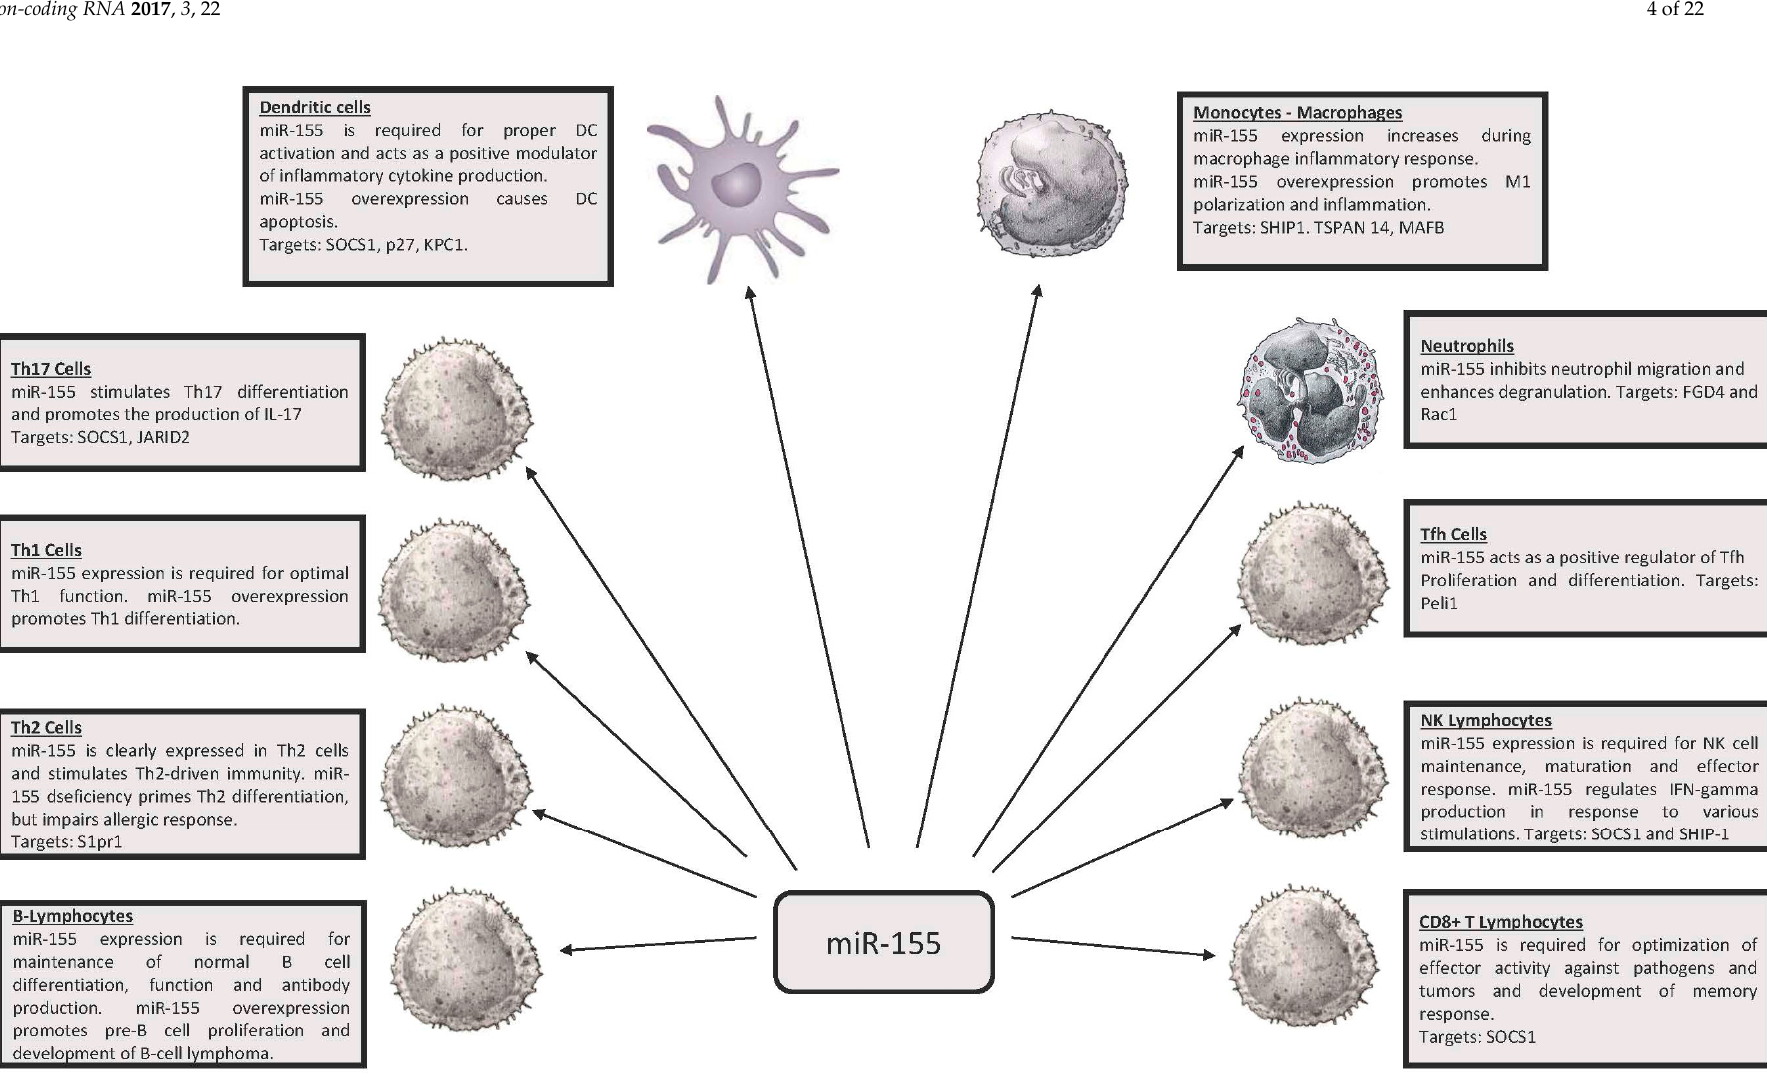
Figure2. Expression and function of miR ‐ 155 in various cell types of the immune system. DC: Dendritic Cell. NK: Natural Killer. Figure 2. Expression and function of miR-155 in various cell types of the immune system. DC: Dendritic Cell. NK: Natural